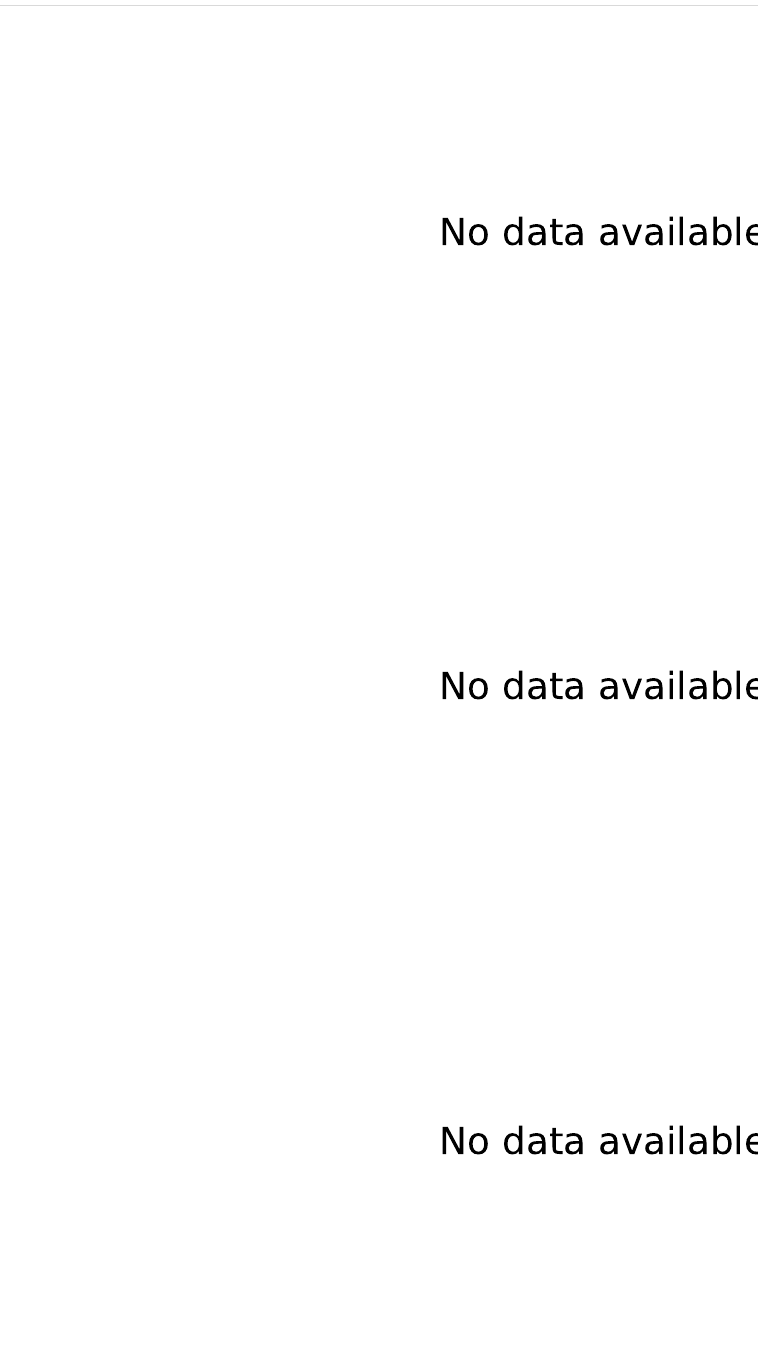
Figure 10: Time trends in cervical cancer incidence in Peru (cancer registry